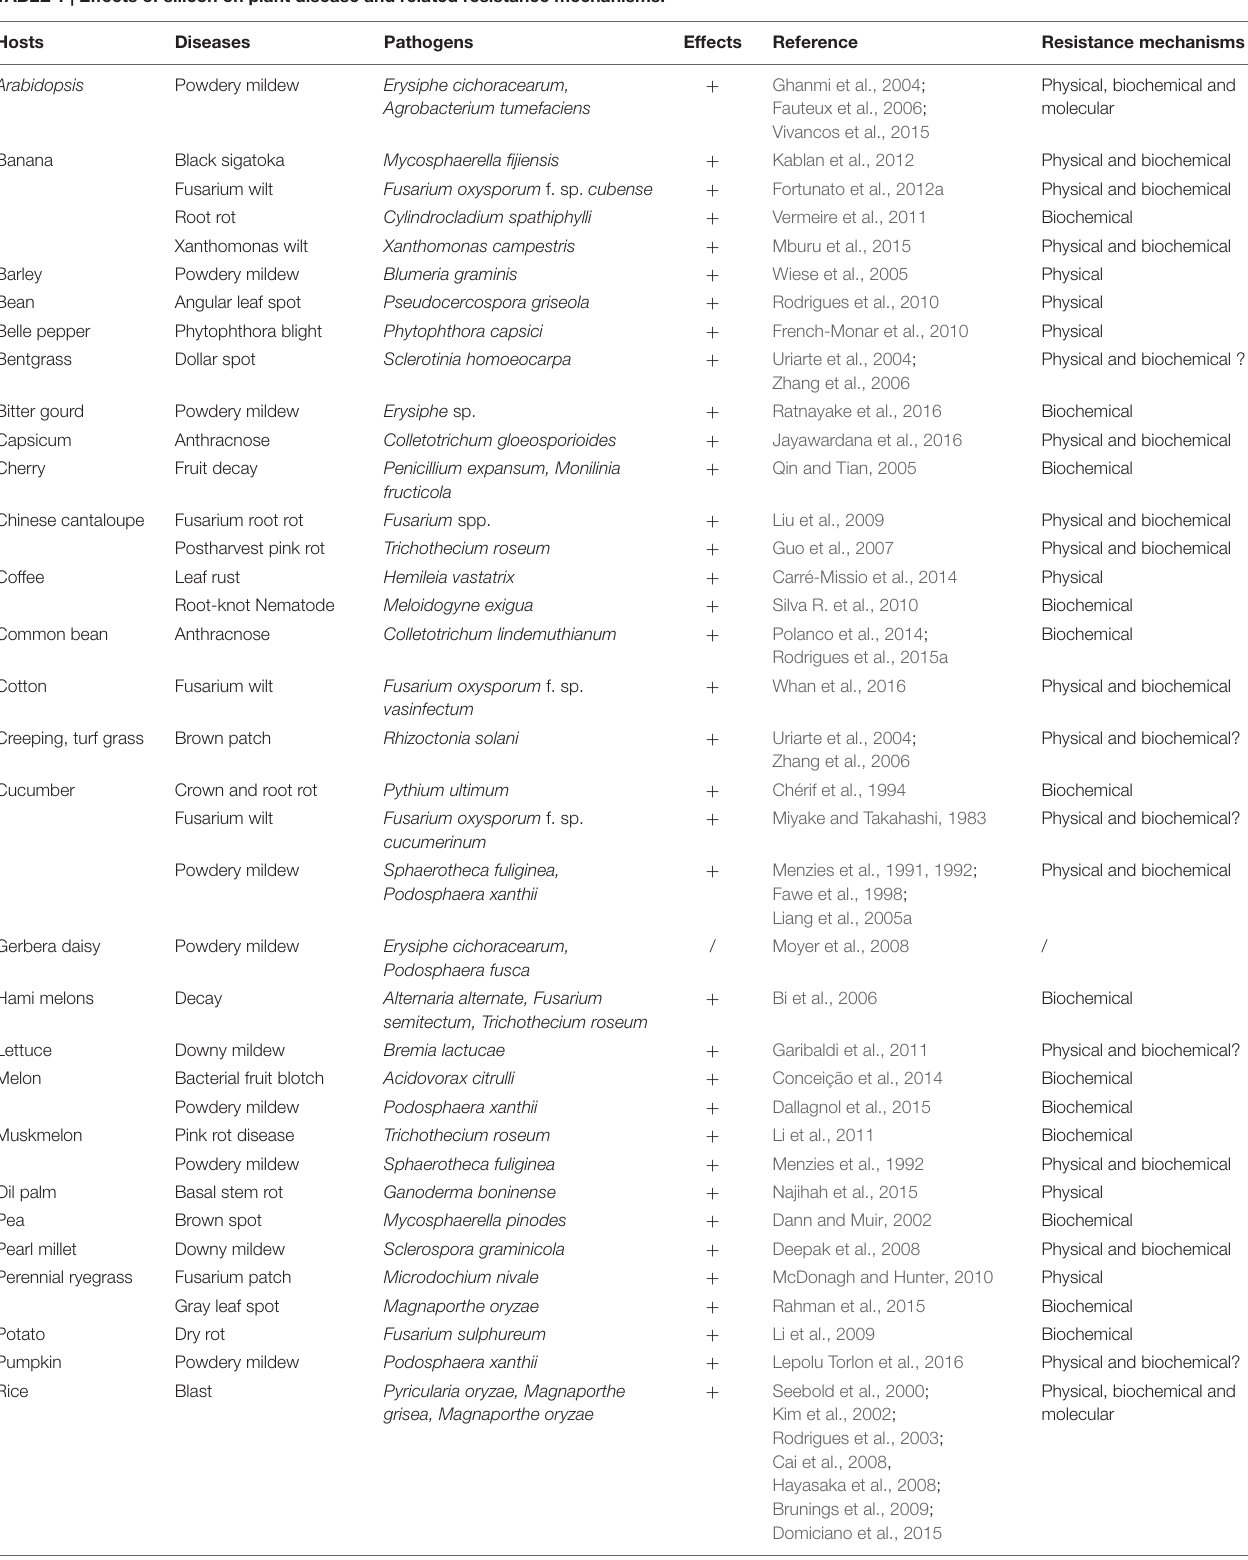
TABLE 1 | Effects of silicon on plant disease and related resistance